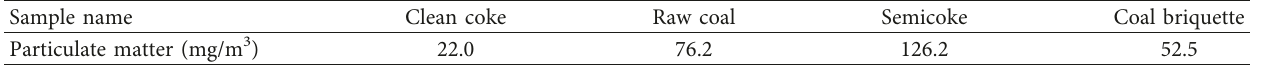
Table 7: Concentrations of PM in the flue gas resulting from the combustion of various carbon-based fuels. Sample